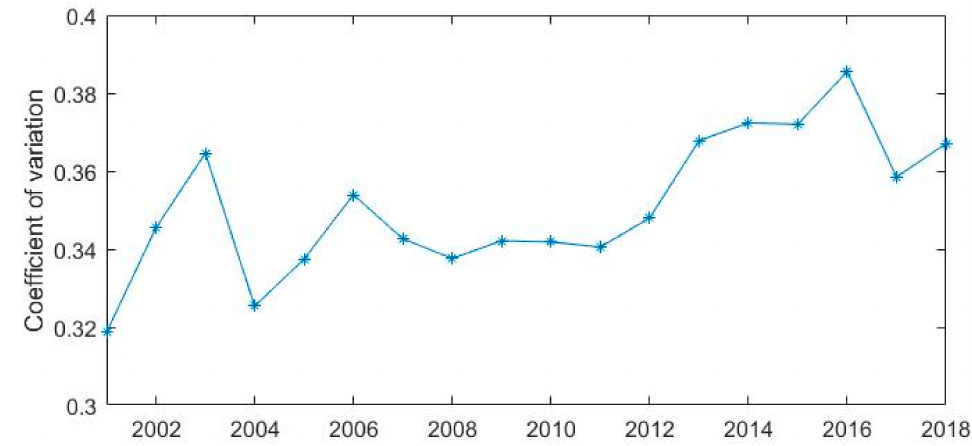
Figure A2. The annual coefficient of variation in PM 2.5 over eastern China from 2001 to